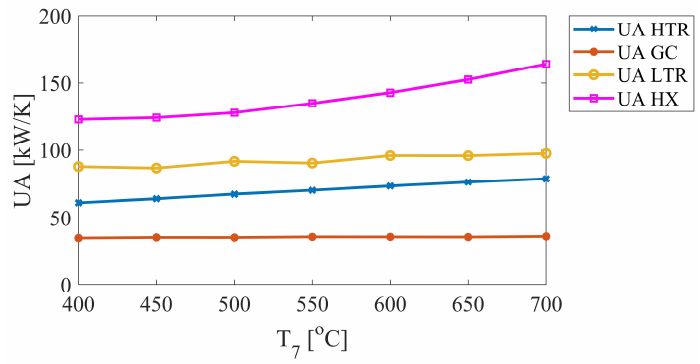
Figure 10. Heat transfer area coefficient ( UA ) vs. turbine inlet temperature ( T 7 ).